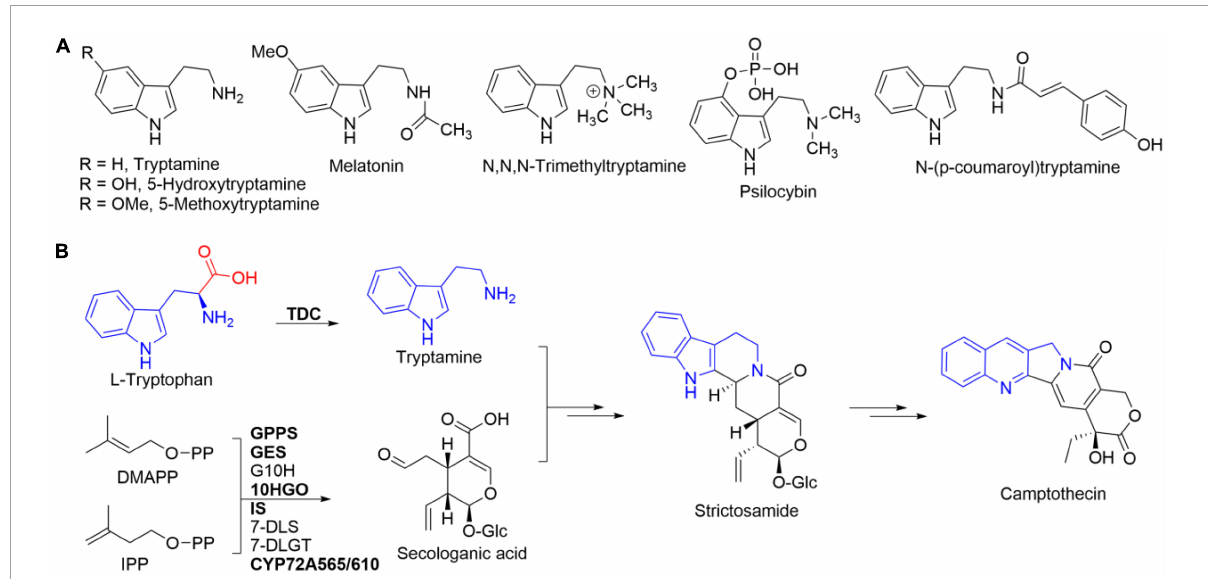
FIGURE1 Tryptamine and its representative analogs (A) and L-tryptophan’s integration into camptothecin via tryptamine (B) . Tryptamine is originated from the decarboxylation of L-tryptophan catalyzed by tryptophan decarboxylase (TDC). Enzymes in bold represented those that have been functionally